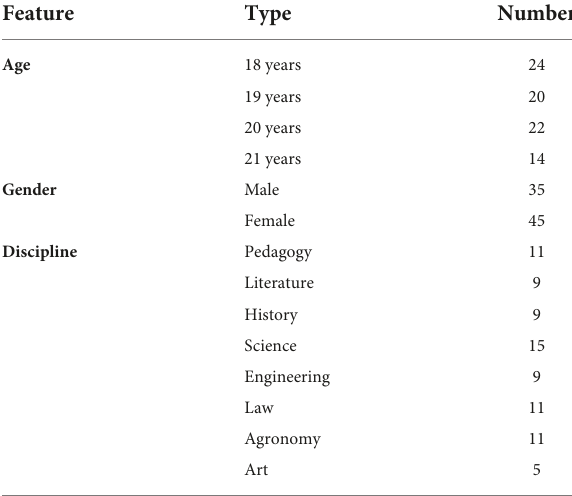
TABLE 1 The background information of the